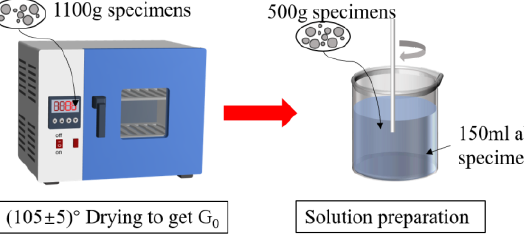
Figure 1. ( a ) the 8-shaped mold; ( b ) semicircular bend specimen.